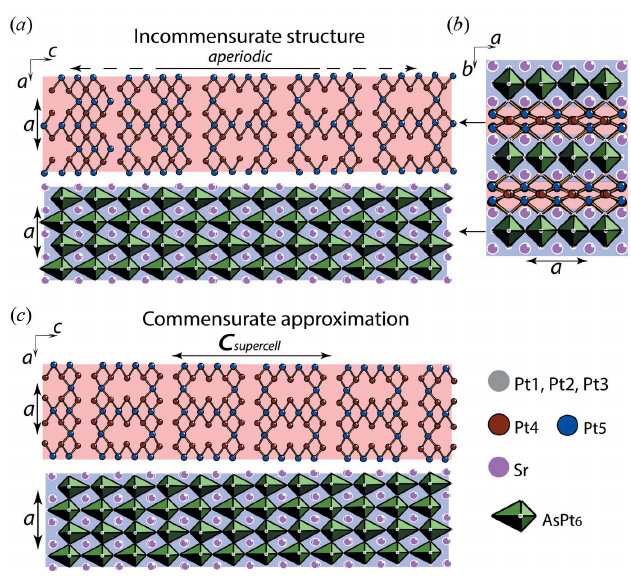
Figure 3 Sketch of the crystal structure of Sr 2 Pt 8 (cid:2) x As. ( a ) and ( b ) are portions of the Sr 2 Pt 7.285 As IM structure with the modulation wavevector q = 0.6038 c *. ( b ) and ( c ) represent the commensurate superstructure approximation with q = 0.6 c *. Different colours show five different atomic sites of Pt, Pt1, Pt2 and Pt3 (grey) forming a layer of edge-sharing AsPt 6 bipyramids (green) centred by As (blue background). This layer of AsPt 6 bipyramids is identical in both the IM structure and its commensurate approximation. Pt4 (brown) and Pt5 (blue) form the ‘metallic’ corrugated grids (red background), which are aperiodic along the c axis in the IM structure. The short Pt–Pt contacts of 2.4–2.74 A˚ are shown by